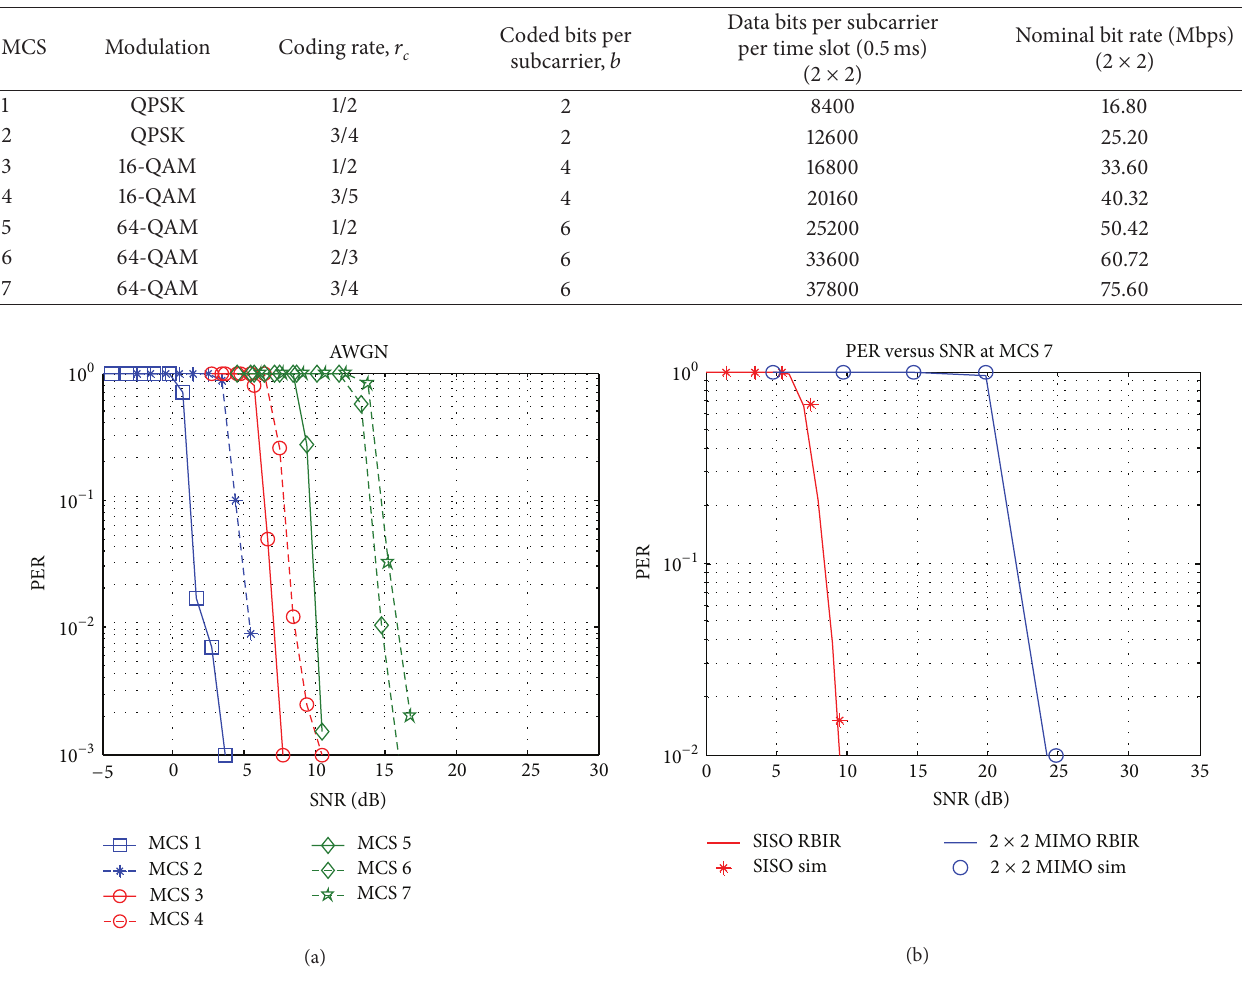
Table 2: MCS PHY layer in 10MHz bandwidth.